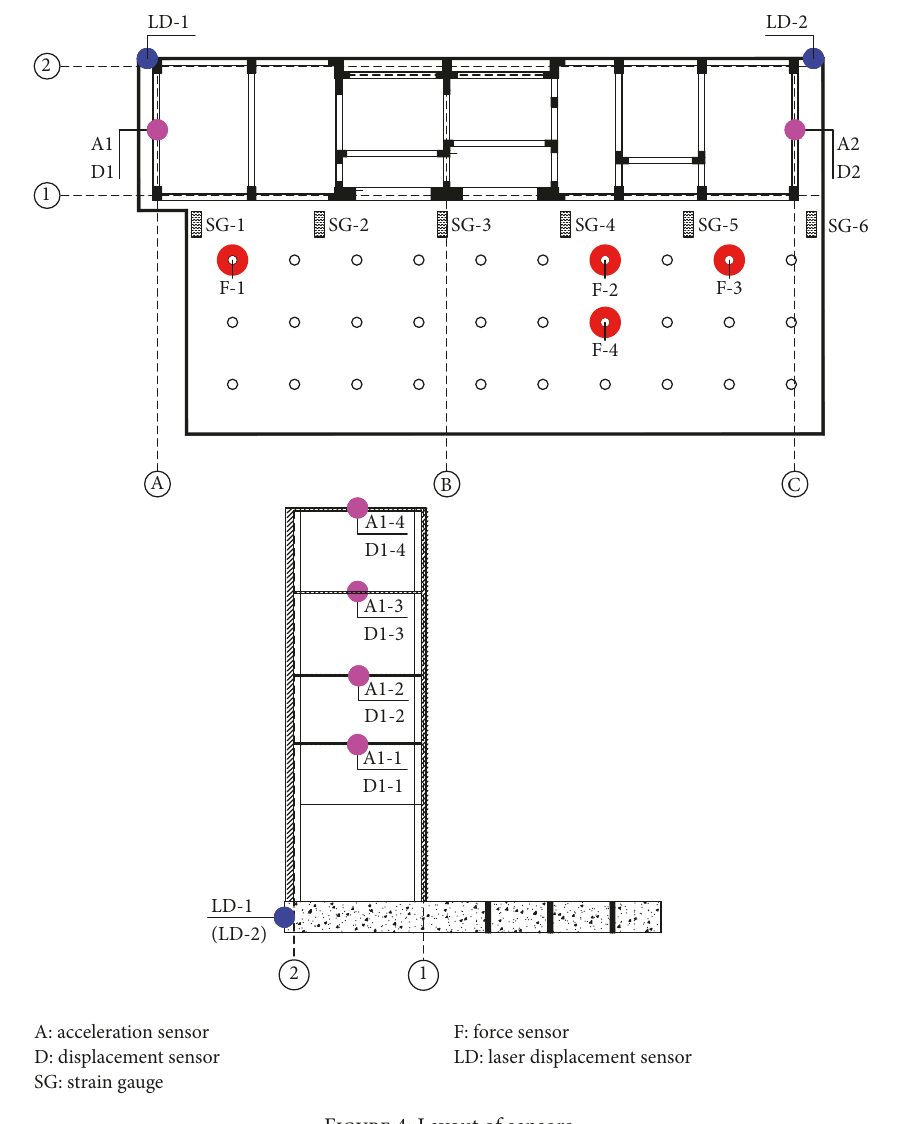
Figure 4: Layout of